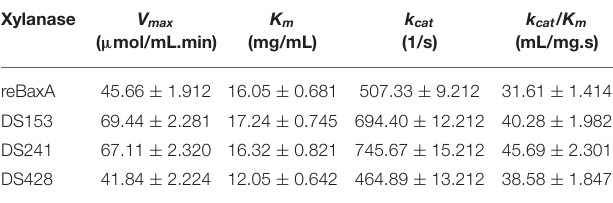
TABLE 1 | Kinetic constants of xylanase. Xylanase V max ( µ